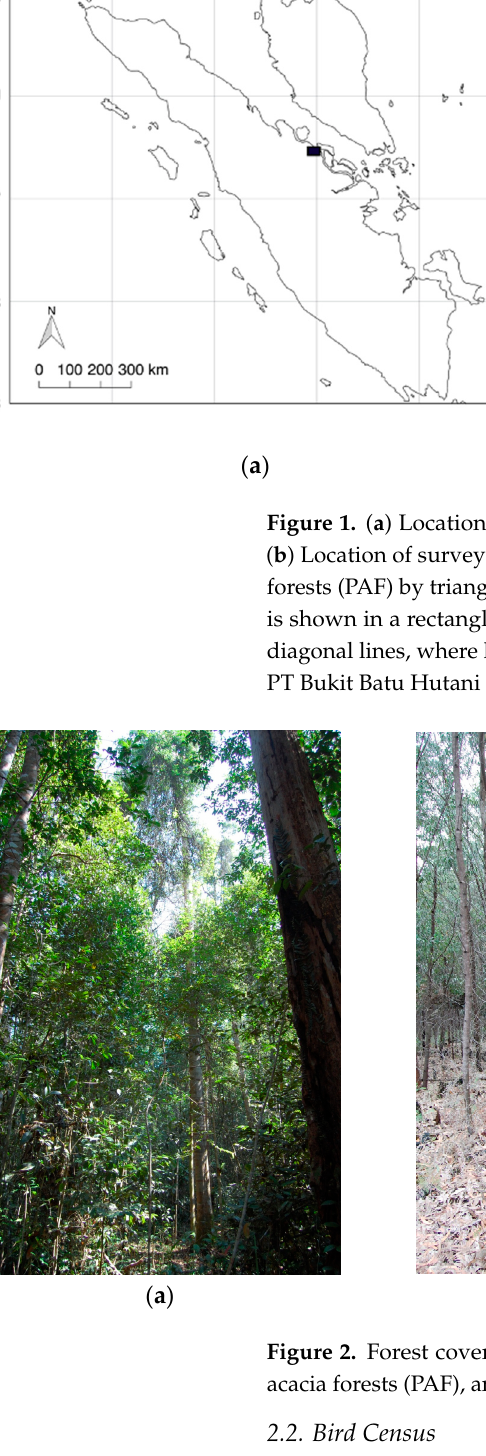
Figure 2. Forest cover types in the study area: ( a ) natural peat swamp forests (NPF), ( b ) planted acacia forests (PAF), and ( c ) jungle rubber forests (JRF).